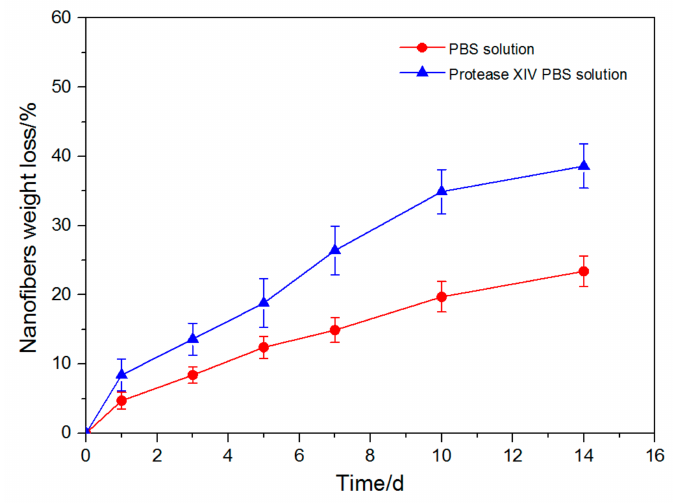
Figure 10. Degradation of p (ASF-AGE-NIPAAm) hydrogel nanofibers (Nano-6 sample) in the PBS and protease XIV PBS solution at 37 ◦ C.